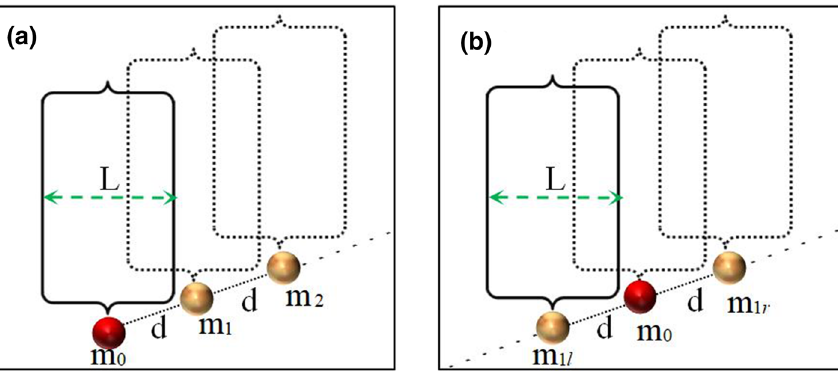
or “ r ” to distinguish the environmental particles to the left or right of the system particle m 0 . The j th (1 ≤ j ≤ n ) particle to the left of m 0 2 has a mass of m jl . The j th (1 ≤ j ≤ n ) particle to the right of m 0 has 2 mass m